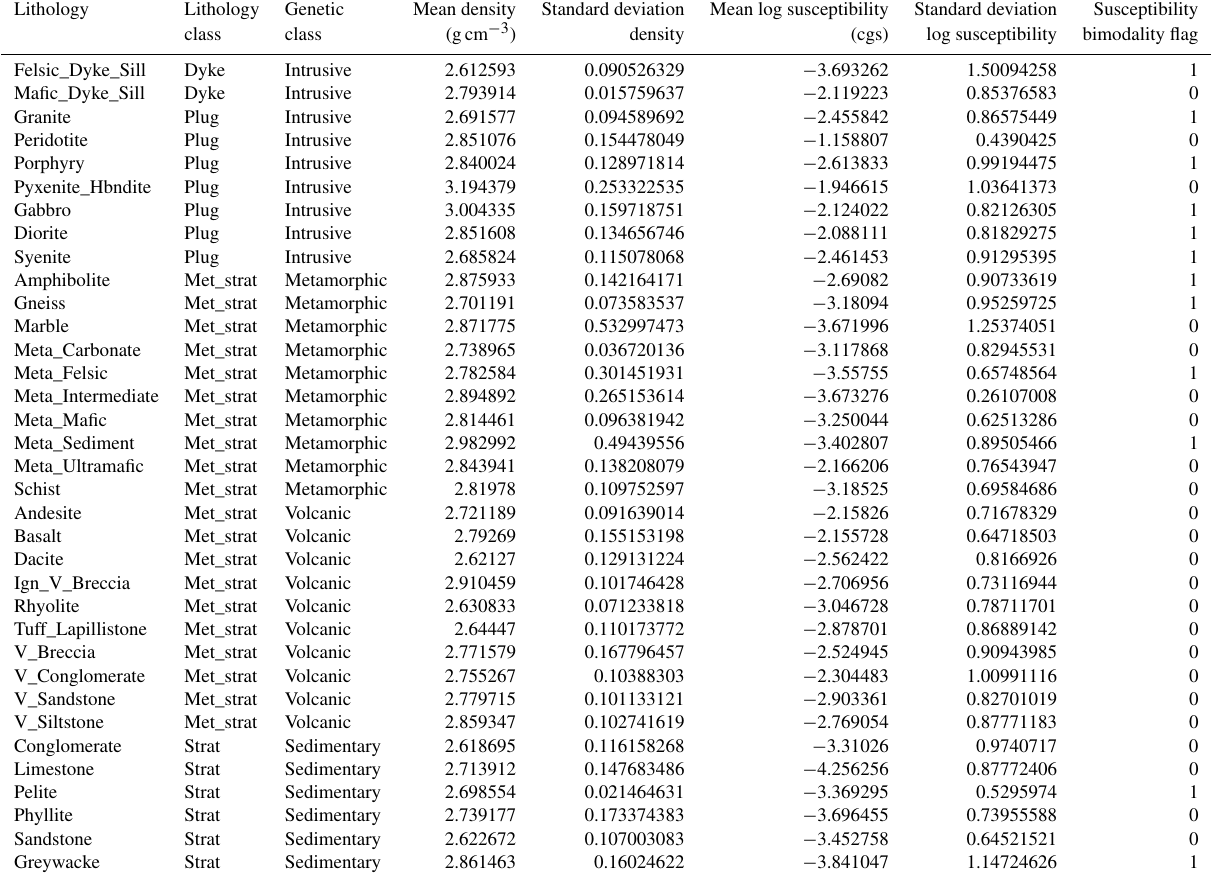
Table 2. Simplified petrophysical values derived from British Columbia database (Geoscience BC, 2008). Values are randomly sampled from Gaussian distributions defined by the mean and standard deviation of density and log magnetic susceptibility. For lithologies with bimodal magnetic susceptibilities (flag of 1), mixed sampling is based on offsetting the means by ± 0.75 orders of magnitude, which approximates the variations seen in nature. V_ is short for